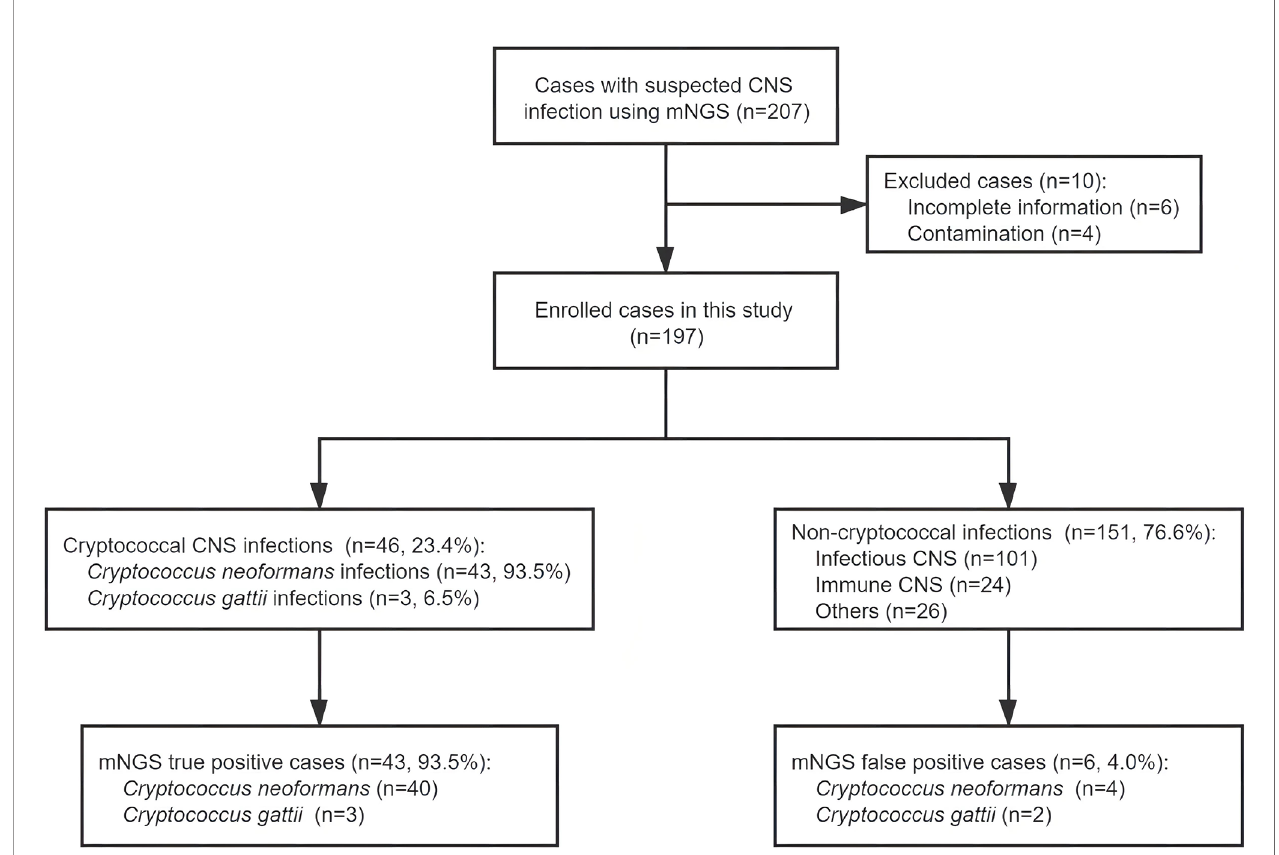
FIGURE 1 | Overview of patient enrollment, metagenomic next-generation sequencing (mNGS) results, and etiological diagnoses. After exclusion of 10 cases, 197 patients with suspected central nervous system (CNS) infection were enrolled in this study. Of these patients, 46 were diagnosed with cryptococcal CNS infection by at least one routine cryptococcal diagnostic test; the other 151 cases were diagnosed with non-cryptococcal infections. The sensitivity and speci fi city of mNGS in detecting Cryptococcus were 93.5% and 96.0%,